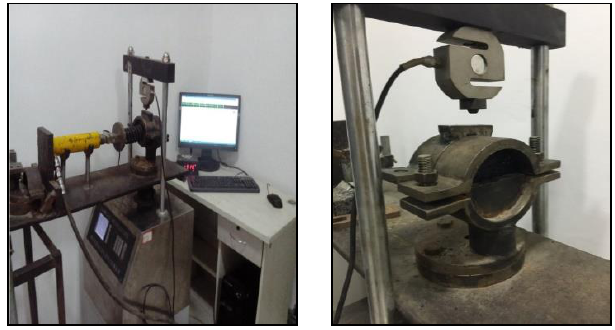
Figure 9. The direct shear test set up.